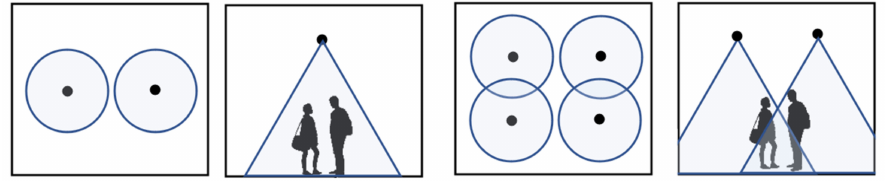
Figure 5. Illustration of the overlaps between multiple microphones’ cone of